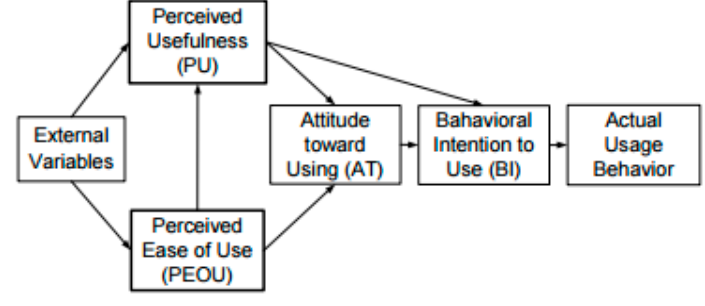
Figure 1. Technology Acceptance Model.